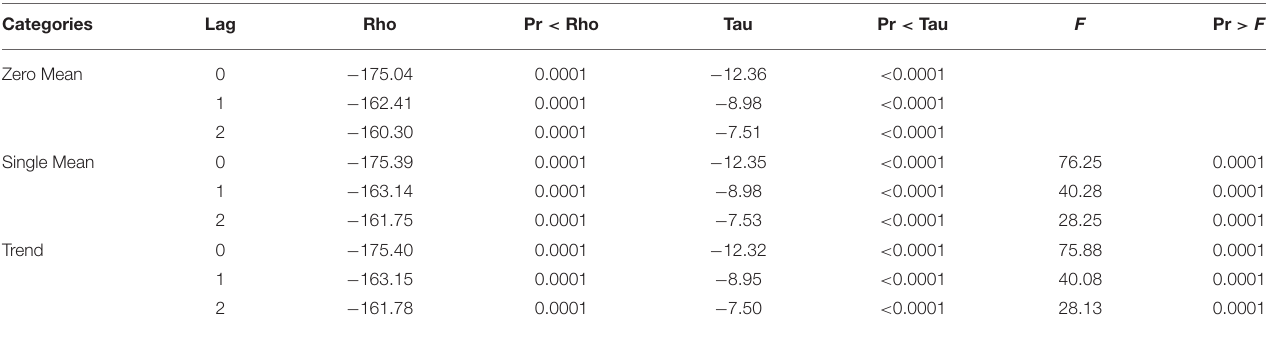
TABLE 5 | Unit Root Test Results of